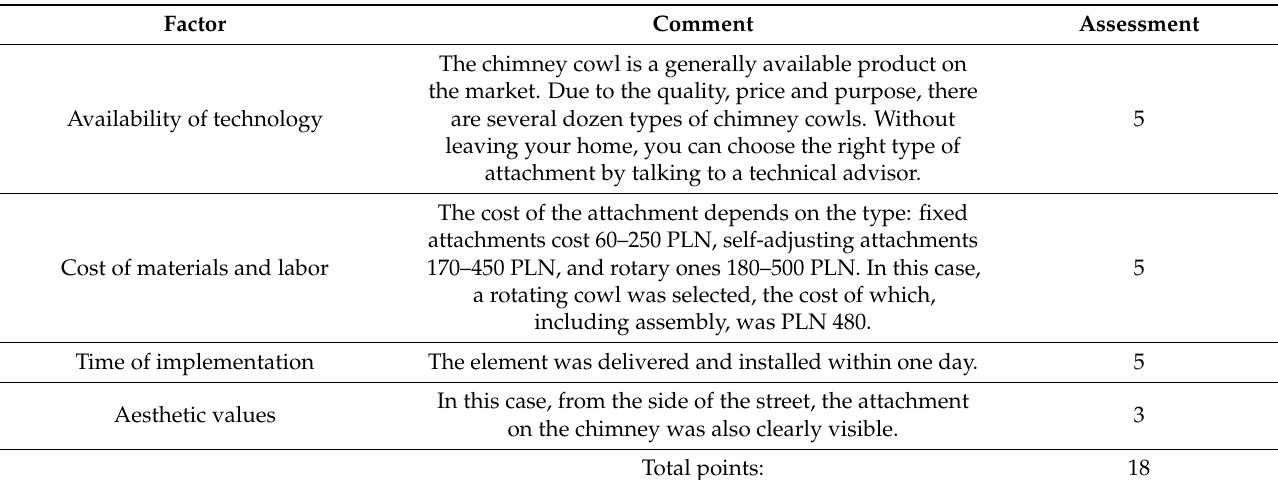
Table 5. Assessment of the applied solution to strengthen the chimney draft.